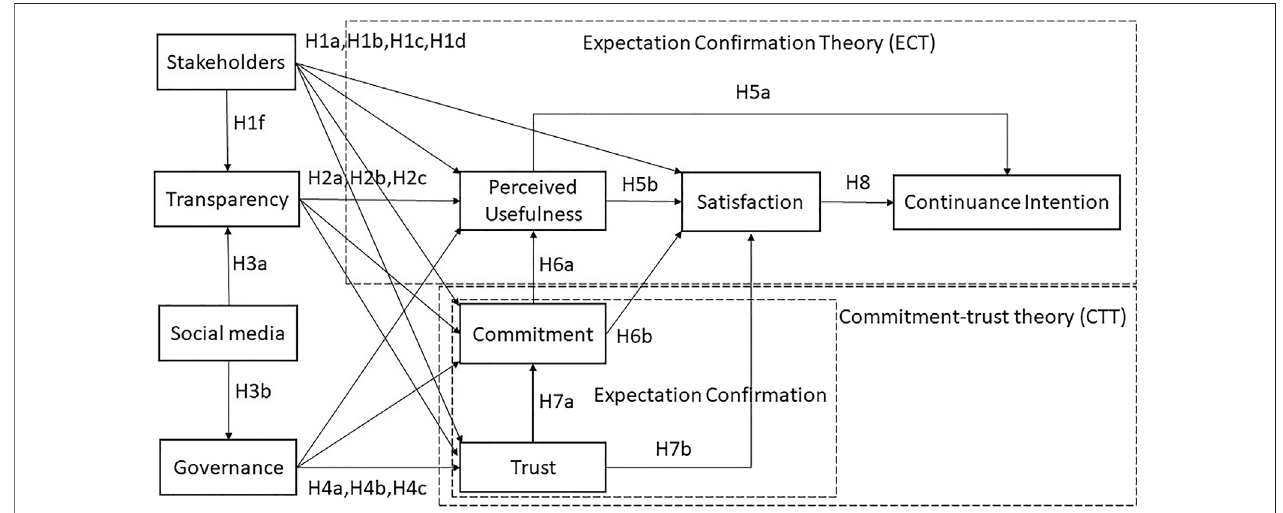
FIGURE 1 | The research